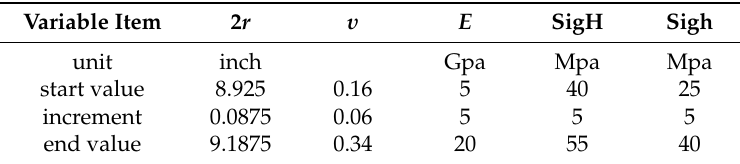
Table 2. Parameters used for the generation of training and testing data.